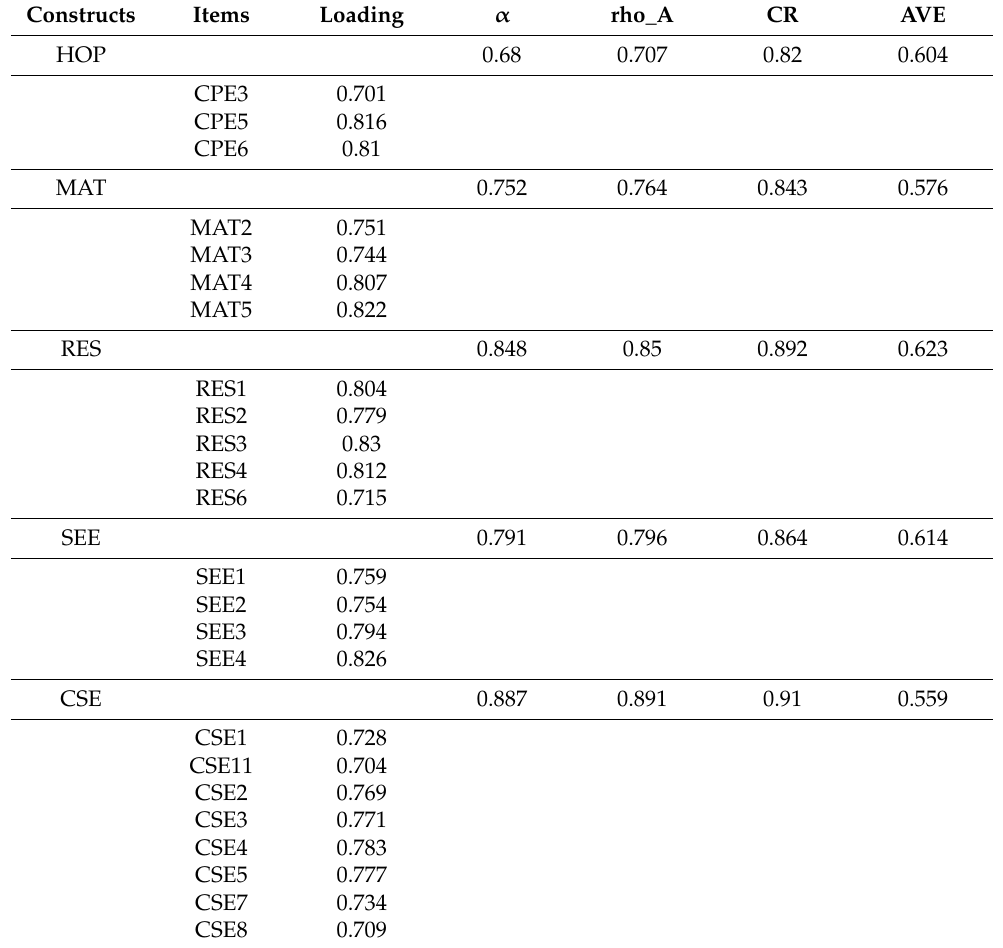
Table 2. Measurement model